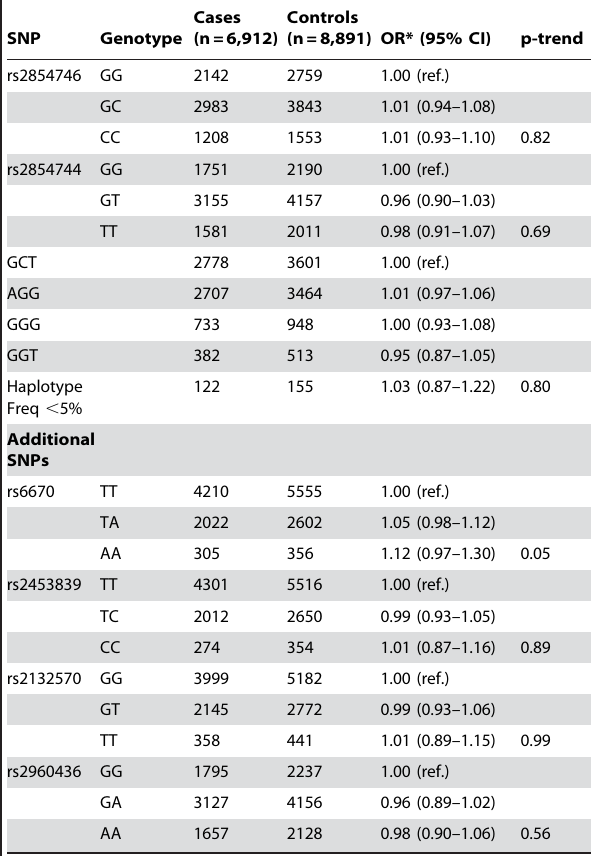
Table 4. Association of tagging SNPs of IGFBP1 and IGFBP3 and breast cancer risk in the